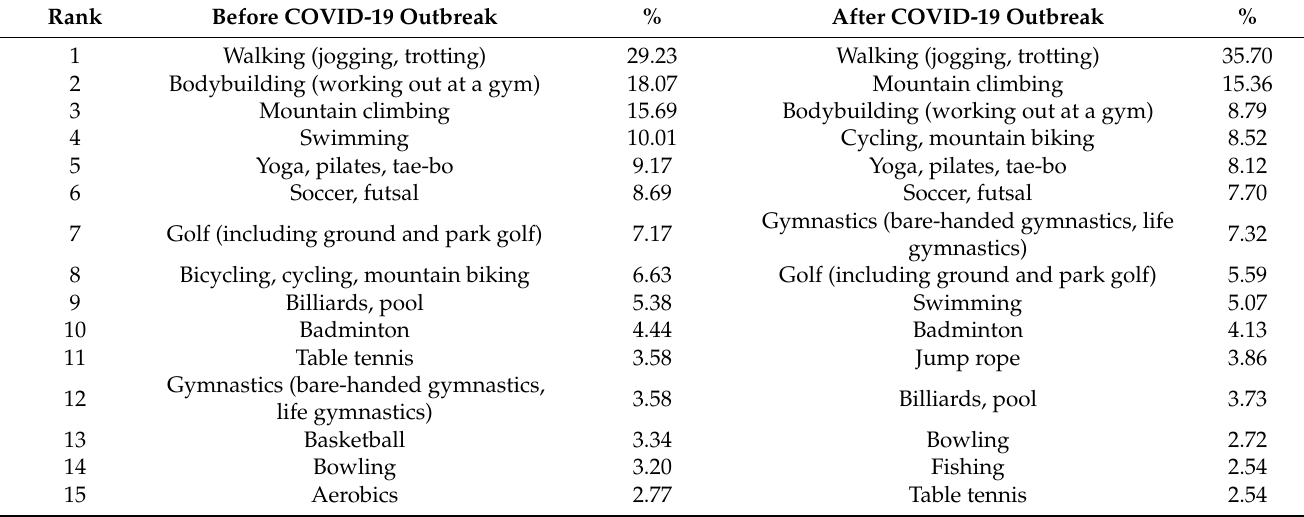
Table 6. Changes in regular participation in sports activities due to the COVID-19 outbreak (1 + 2 + 3 ranking among respondents who have changed their participation patterns after COVID-19 outbreak; top 15 sports, unit: